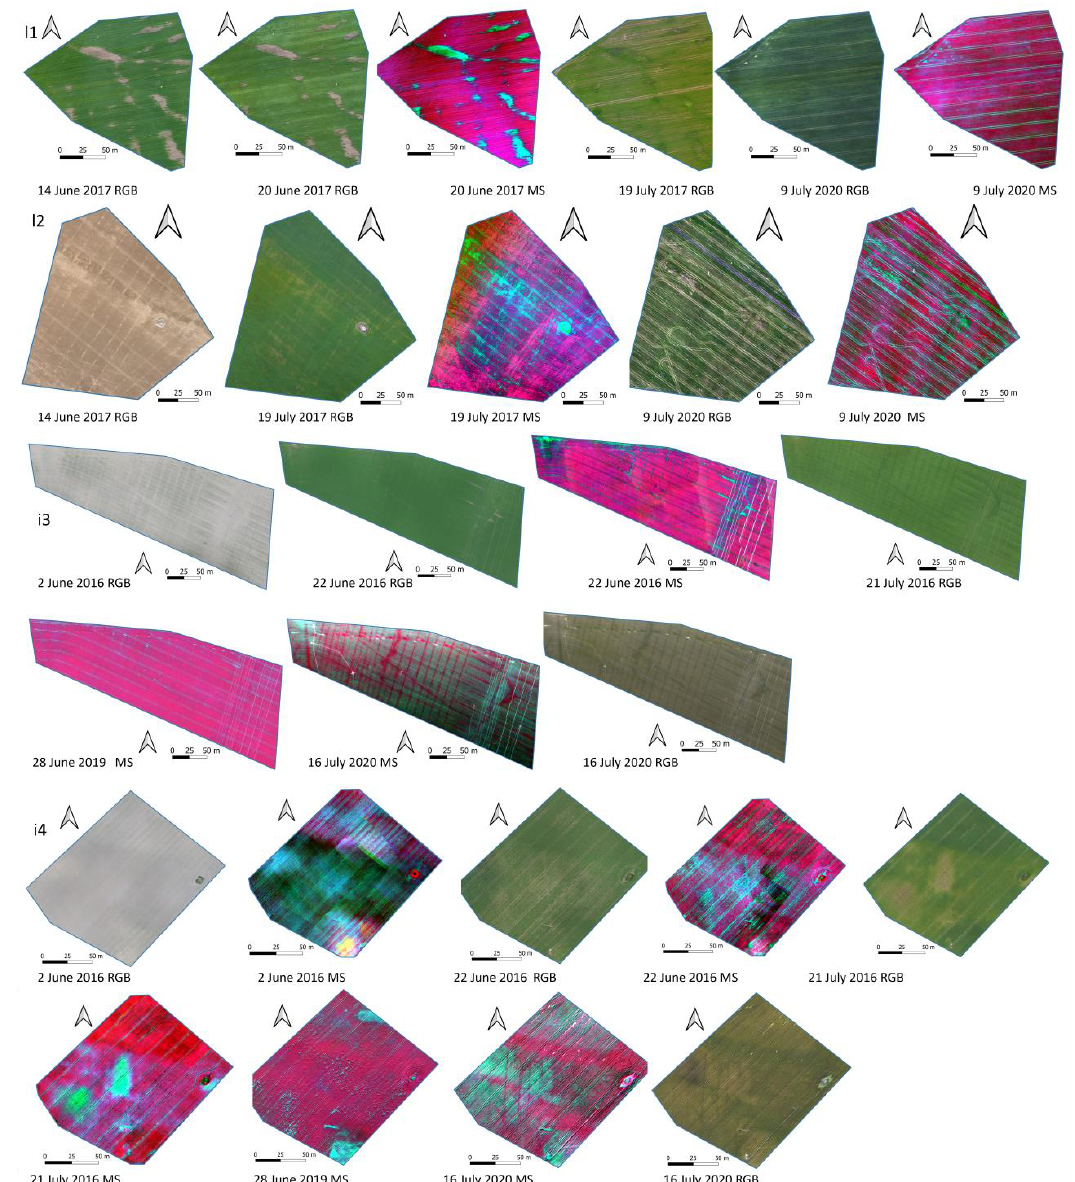
Figure 2. Orthomosaics generated from drone images for all real farm fields in order of the data collection date (Table 2). Color infrared (CIR) mosaics were visualized from MS.